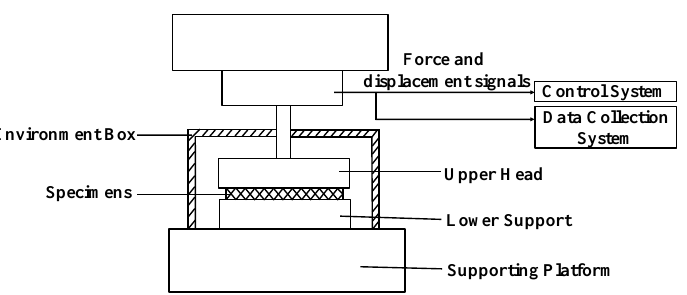
Figure 4. Schematic of static compression testing system.